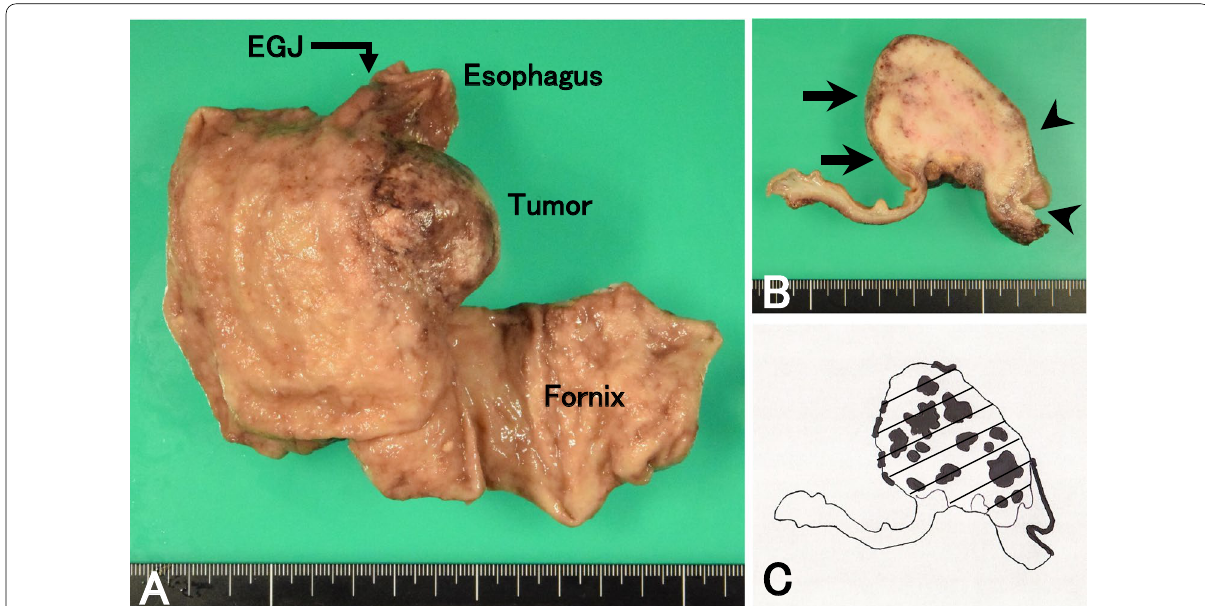
Fig. 4 Macroscopic findings. A Macroscopic findings of the resected specimen. An elevated tumor is mainly located in the gastric cardia. B The cut surface of the tumor. The tumor is covered with the normal squamous mucosa (arrowheads) and the gastric mucosa (arrows). C A schema of the cut surface. Black areas show the adenocarcinoma components, while diagonal area shows the SCC components. The adenocarcinoma component is located diffusely as a focal area in the tumor and occupies 35% of the tumor, while the SCC component is located in the surface to the deep layer of the